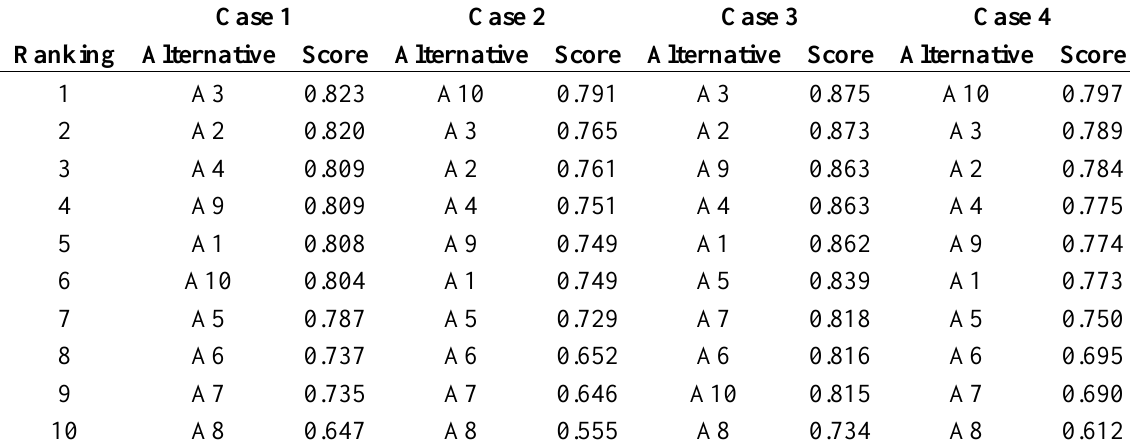
Table 4. The performance score and the ranking order of each alternative for four weighting scenarios.